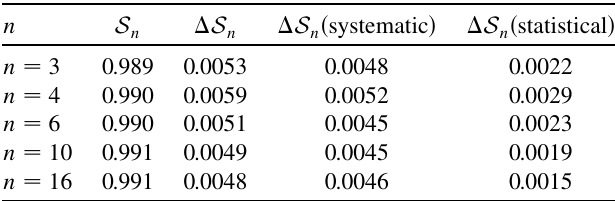
TABLE III. Size of systematic and statistical error factors contributing to (cid:4) S n (Fig. 5 data) without 1-km fiber.